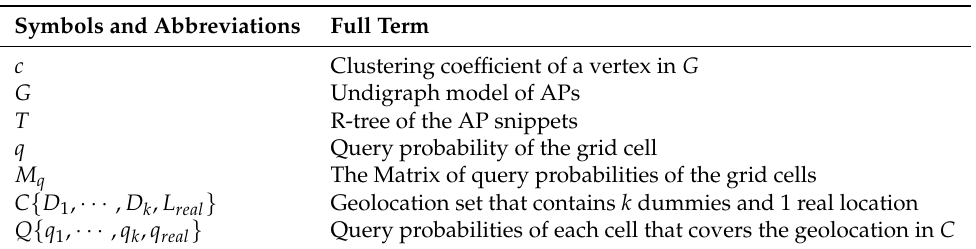
Table 1. Glossary of Symbols and